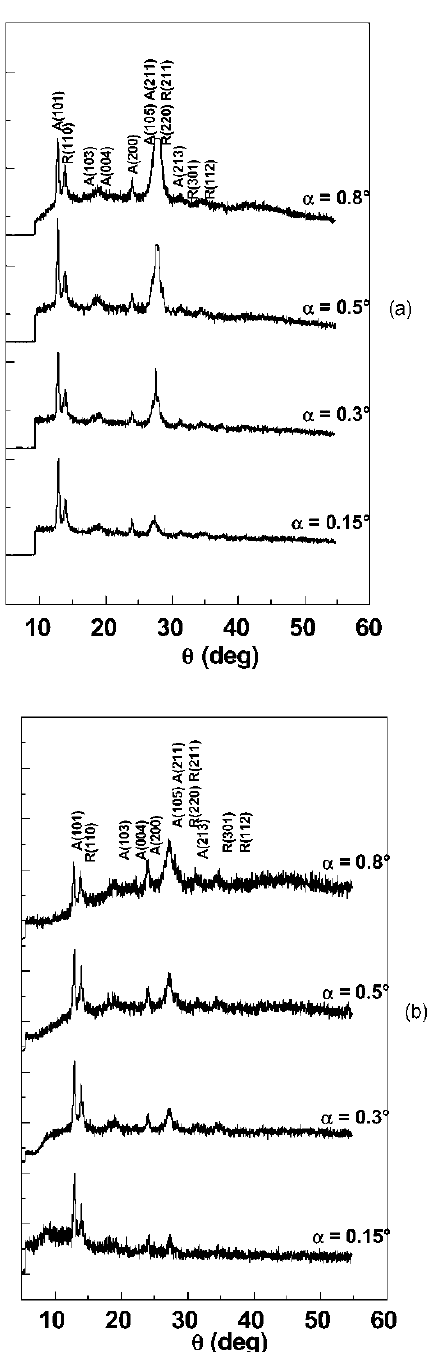
FIGURE 1 Spectres de diffraction des rayons X en incidence rasante ( a ¼ 0.15; 0.3; 0.5; 0.8 (cid:2) ) des structures TiO 2 = c-Si obtenues aux pressions partielles d’oxyge`ne suivantes: (a) 10 (cid:1) 3 mbar, (b) 2 (cid:4) 10 (cid:1) 3 mbar et (c) 5 (cid:4) 10 (cid:1) 4